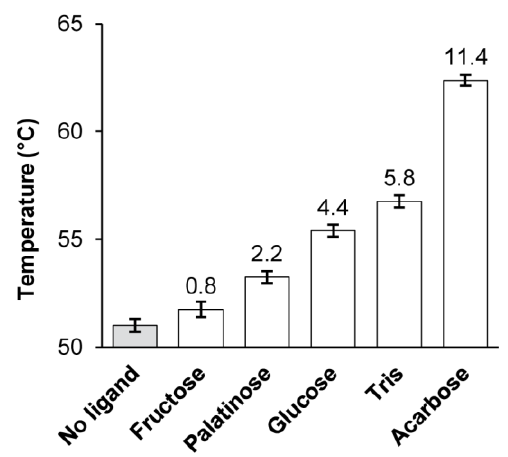
Figure 6. Thermostability of Ba AG2 in the presence and absence of indicated ligands. The T m value of unliganded Ba AG2 (a grey bar) was 51 °C and the increase of T m in the presence of a ligand is indicated above every bar. SDs of at least two independent experiments with two replicates at each condition are shown by error bars.